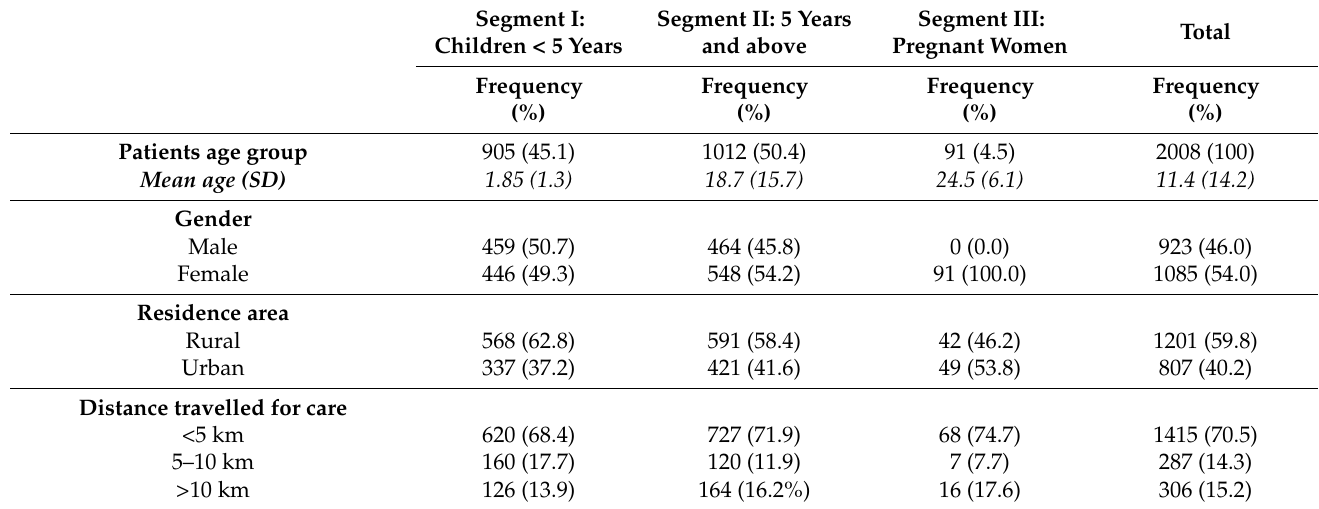
Table 1. Sociodemographic characteristics of study participants during the HF-based survey.